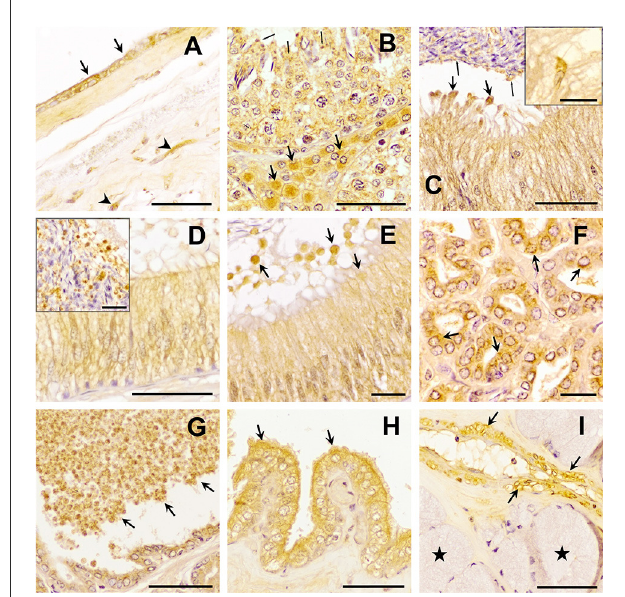
FIGURE3 Immunohistochemistry of Transforming Growth Factor (TGF)- β 2 in pig male reproductive tissues. Immunoreactivity in (A) human amniotic membrane (positive control), present in epithelial (arrows) and mesenchymal (arrowhead) cells; (B) testes, in the cytoplasm of Sertoli cells (arrowhead) and Leydig cells (arrows) and in the residual bodies of the spermatids (thin arrows); (C) caput, (D) corpus, and (E) cauda epididymis, in the cytoplasm of the principal cells and in luminal vesicles that, secreted from principal cells [thick arrows, section (D) ], contained smaller vesicles inside, close to spermatozoa [section (C) thin arrows]; (F, G) prostate, in the cytoplasm of epithelial cells [section (F) , arrows] and luminal vesicles [section (G) arrows]; (H) seminal vesicle, in the cytoplasm and apical blebs (arrows) of epithelial cells; (I) bulbourethral gland, in vascular smooth muscle (arrows), but not in secretory epithelium (stars). Scale bars (A–D, G–I) 50 µ m; (E, F) 20 µ m; [ (C, D) details] 20 µ